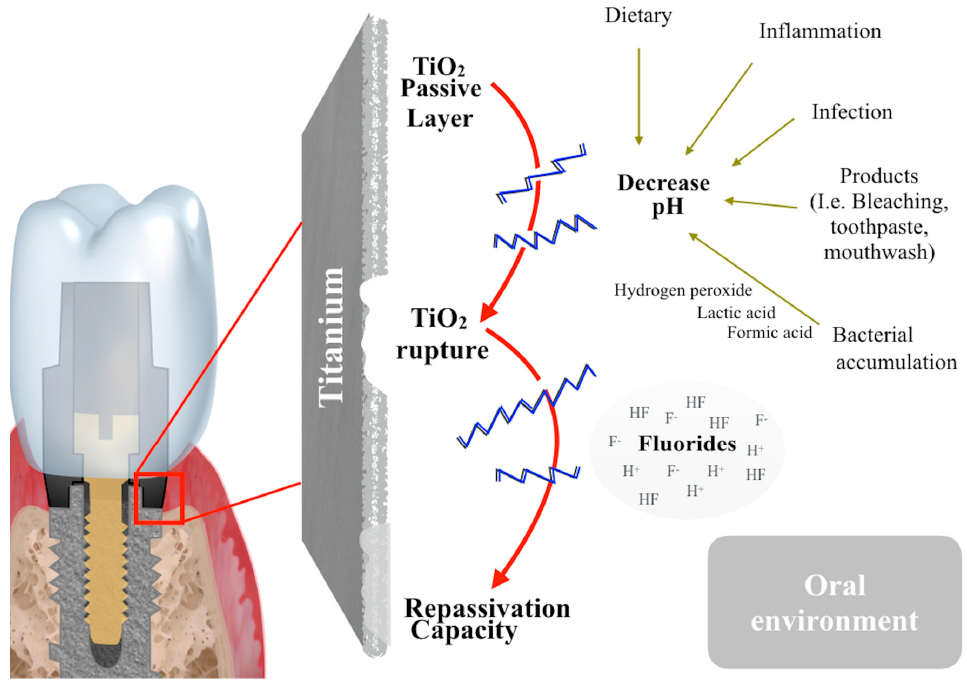
ff ect the corrosion behavior of the Figure 1. Factors that affect the corrosion behavior of the titanium. Figure 1. Factors that a